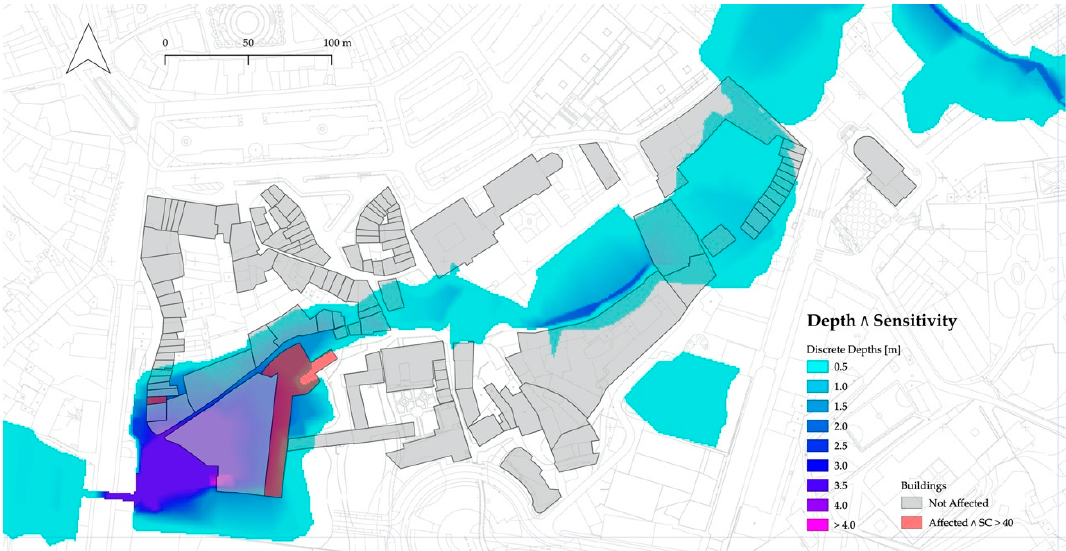
Figure 11. Joint analysis of water depth and the sensitivity